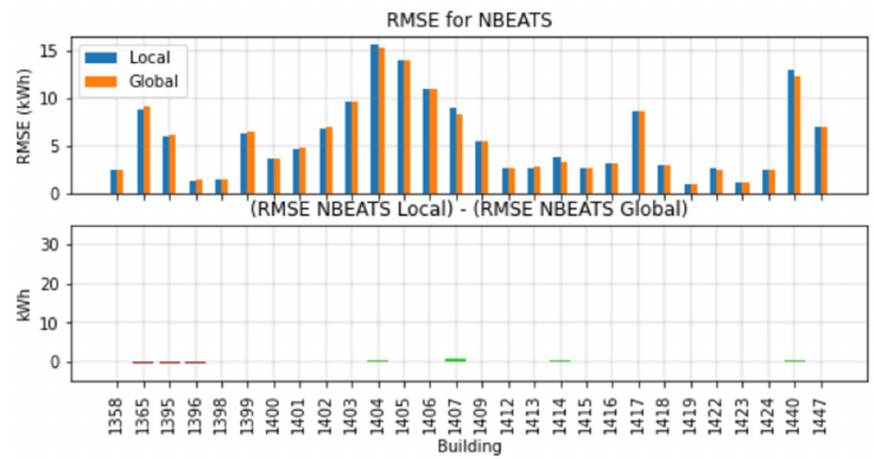
Figure 12. Comparison (in the upper figure) and difference (in the lower figure) between the RMSE obtained from local and global NBEATS models on test set.